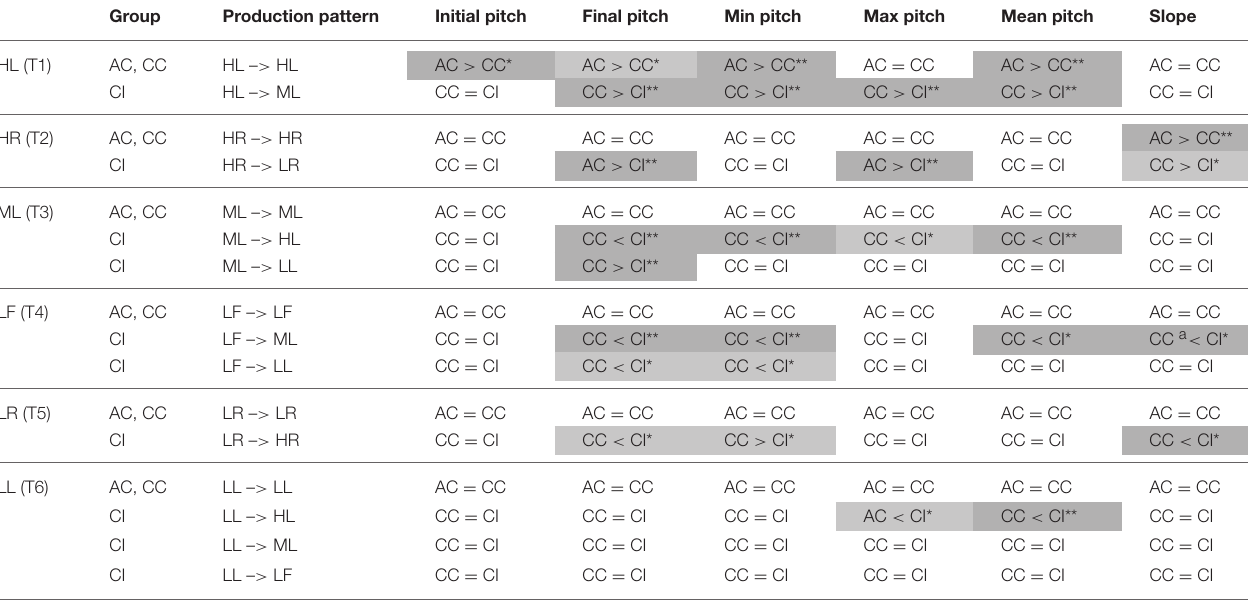
TABLE 5 | Acoustic similarities and differences of correct and incorrect tones produced by children and adults.